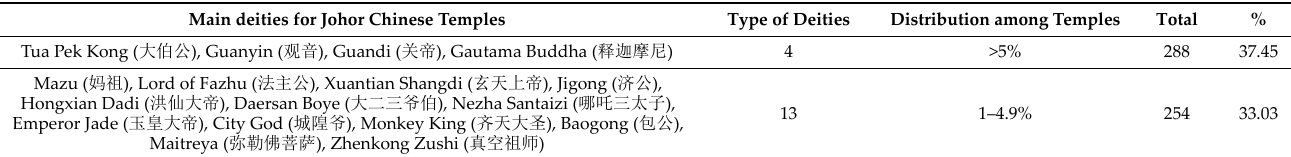
Table 10. Main Deities Founded in Johor